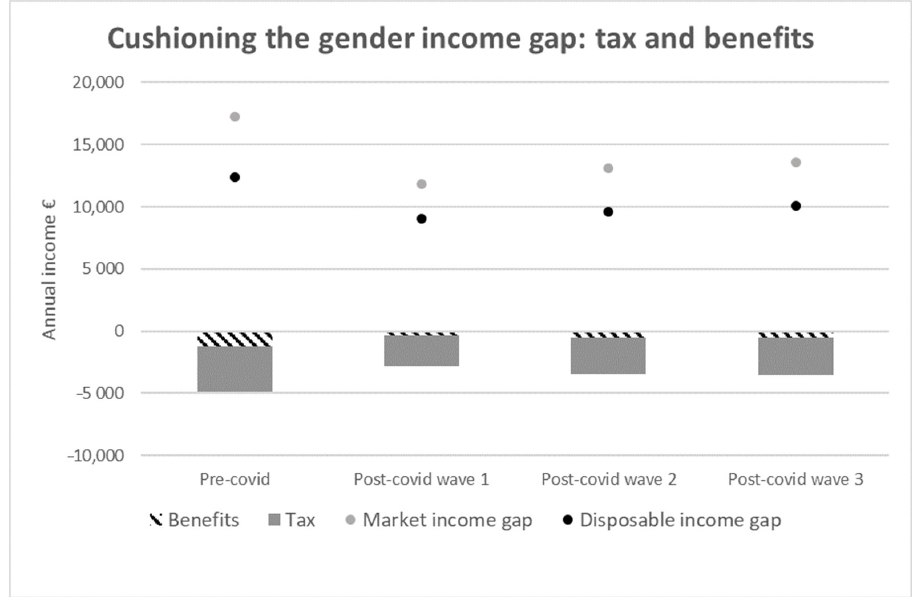
Figure 6. Cushioning effect of taxes and benefits. Source: Own calculations using the NUI Galway microsimulation model linked to 2017 SILC data nowcasted to December 2019 (pre-COVID), May 2020 (wave 1), October 2020 (wave 2) and January 2021 (wave 3). Sample is ≥ 18. Notes: The cushioning effect of the tax and benefit systems correspond to the terms in Equation (2) in Section